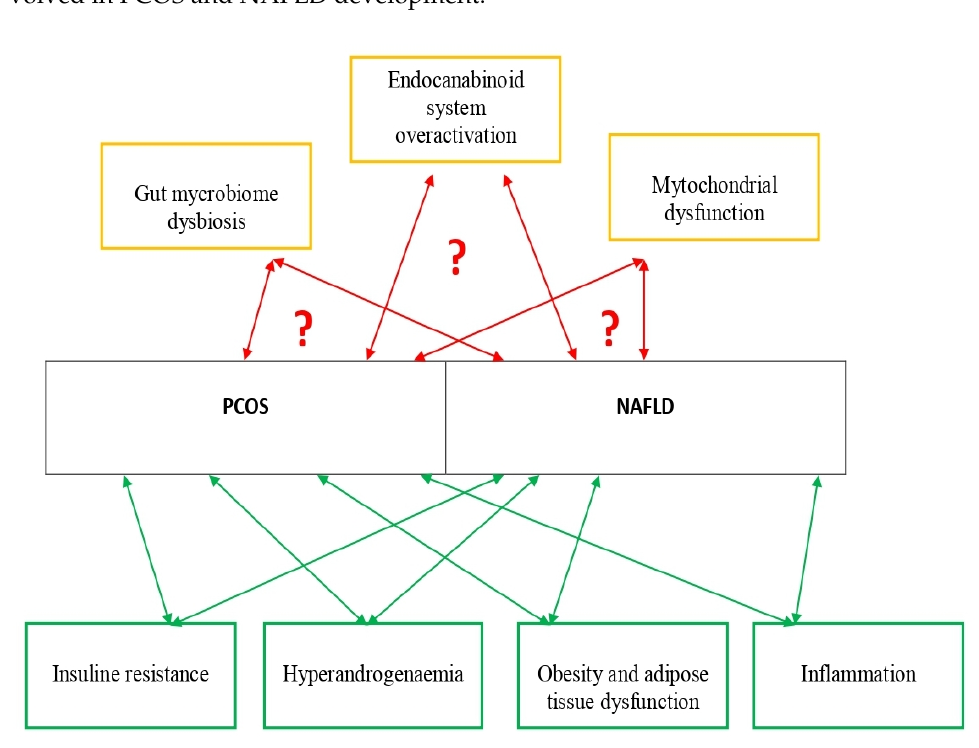
Figure 1. Established and possible new pathophysiological mechanisms involved in PCOS and NAFLD development. Studies about established pathophysiological mechanisms involved in PCOS and NAFLD are presented in Table 1. Studies about possible new pathophysiological mechanisms involved in PCOS and NAFLD are presented in Table 2.